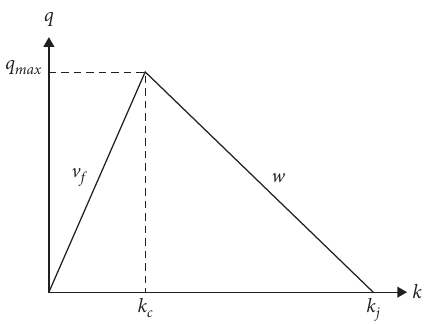
Figure 6: Fundamental diagram of mixed traffic flow.